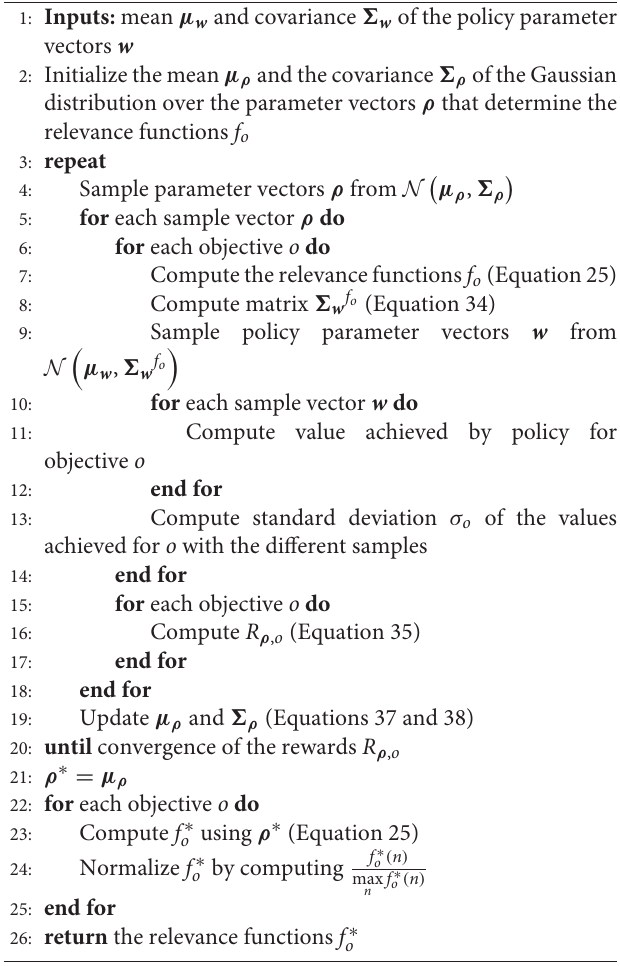
Algorithm 4 Learning Relevance